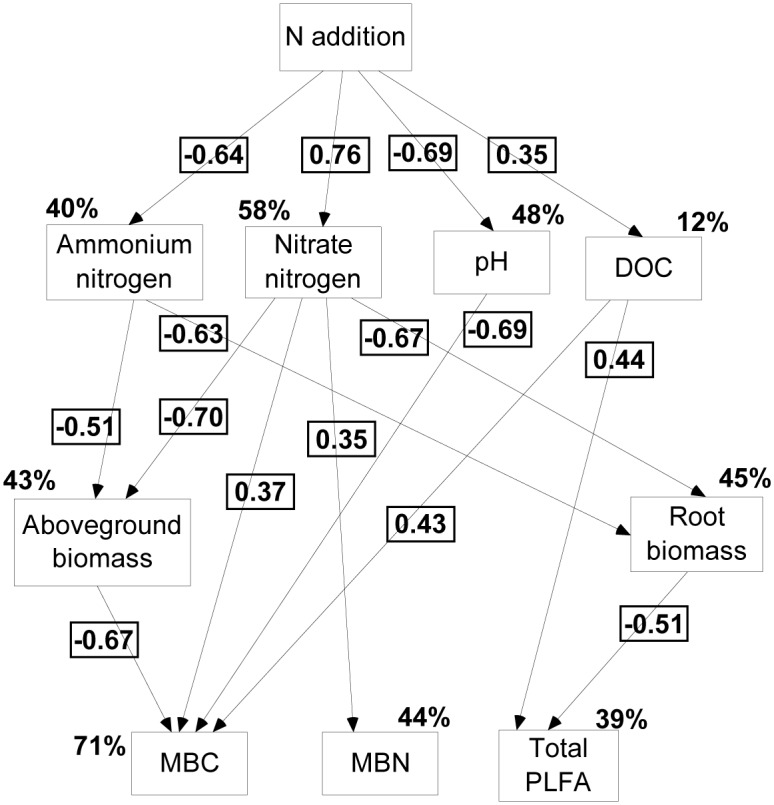
Structural equation model (SEM) of N addition effects on the plant-soil-microbe system.Examining the multivariate effects on soil microbial total PLFA, MBC, and MBN through hypothetical pathways of soil (nitrate N, ammonium N and DOC content, and pH) and plant (aboveground and root biomass) properties. The final model fit the data well: χ215 = 8.158, P = 0.137, Akaike Information Criteria (AIC) = 130.000, RMSEA = 0.313. Percentages close to endogenous variables indicate the proportion of variation explained by the model (R2). Numbers at arrows are standardized path coefficients represent the pathways have significant effects (P < 0.05). MBC, microbial biomass carbon, MBN, microbial biomass nitrogen, DOC, dissolved organic carbon.